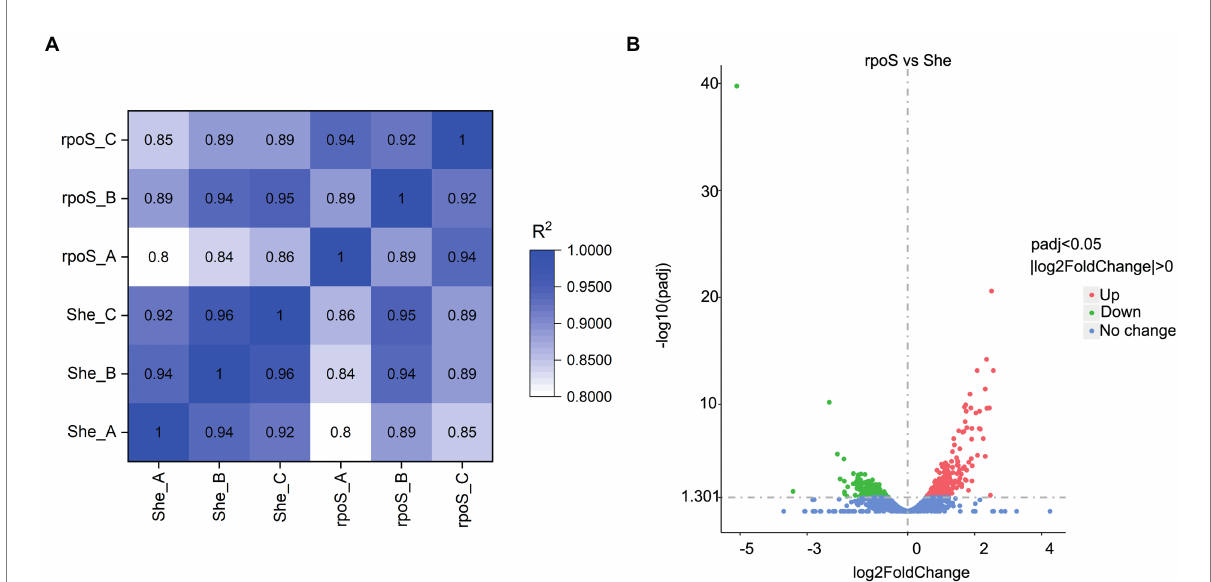
FIGURE 3 The heat-map of Pearson correlation coefficients based on gene expression levels (A) . Volcano plots of different expressed genes (B) . “She” indicates Shewanella baltica wild type, “ rpoS ” indicates the rpoS